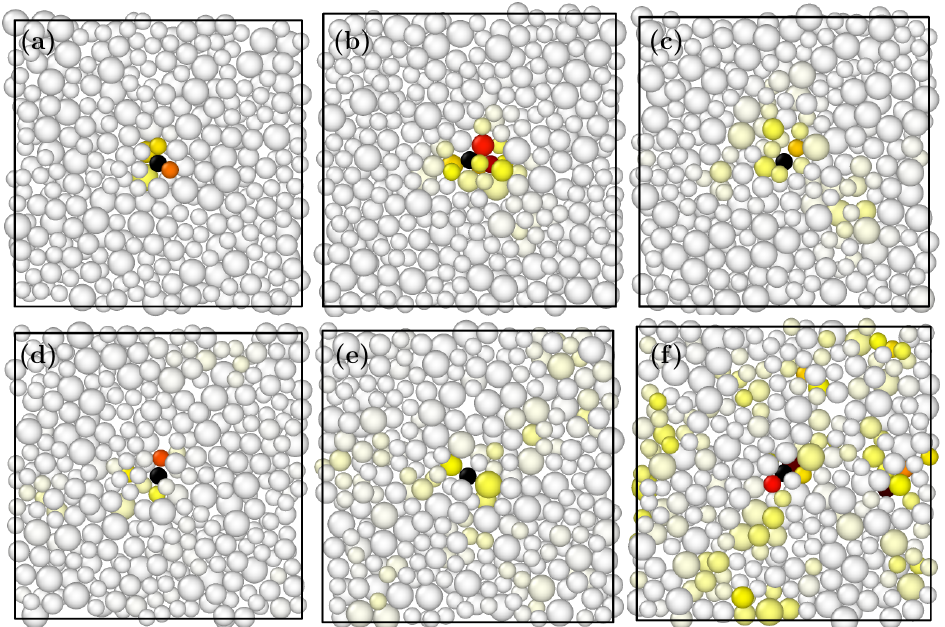
Figure 6: Spatial distribution of the local energy δ E α Each snapshot represents a slab of width 1.5. The particles with the most negative δ E α , i are placed at the center of the squares. The particles with darker colors have more negative energy, while particles with positive energy are colored white.